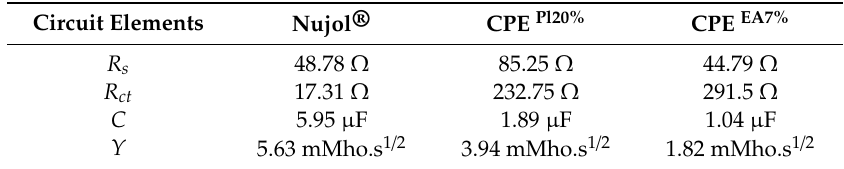
Table 3. Randles equivalent circuit elements for each electrode system evaluated .